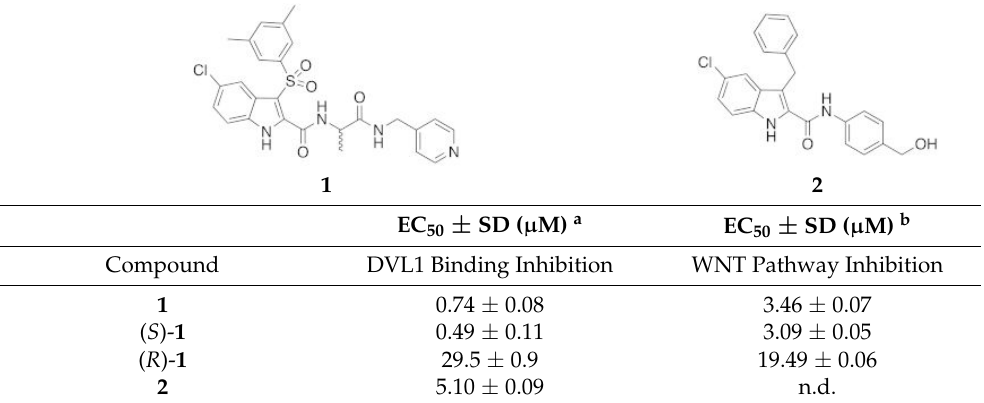
Table 1. DVL Binding and WNT Pathway Inhibition by Compounds 1 , ( S )- 1 , ( R )- 1 and 2